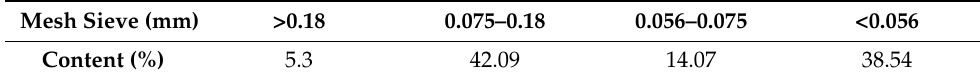
Table A2. Sieve analysis of zinc dust.